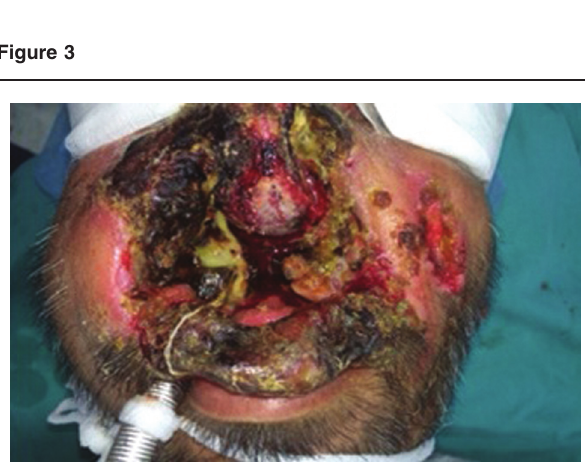
Intraoperative image showing the necrotic lymphoproliferative disorder. Differentials included peripheral T-cell lymphoma and natural killer (NK)/T- cell lymphoma. Immunohistochemical staining showed